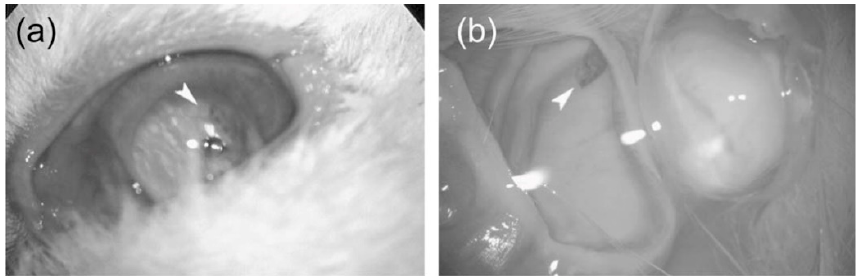
Figure 12. In vivo biocompatibility tests performed on a polyimide (PI2525) microelectrode array (3 ×